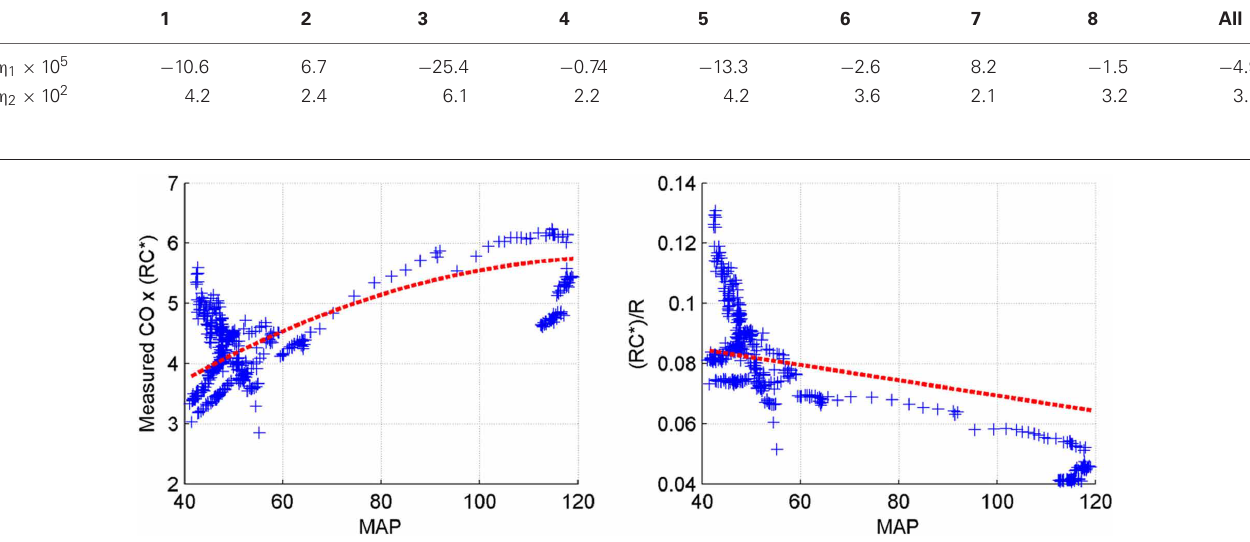
Table 4 | Model of pressure-dependent arterial compliance.